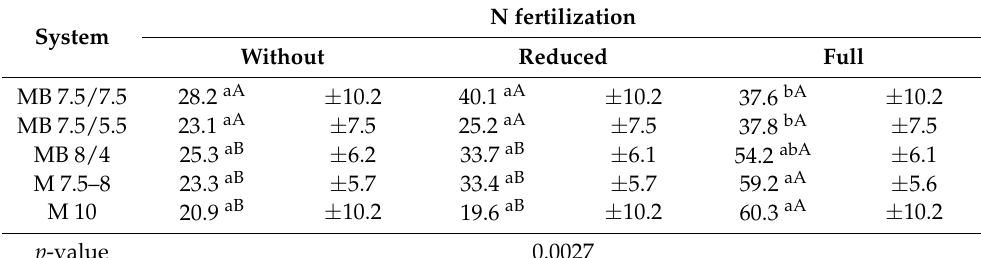
Table 5. Result for N min at harvest